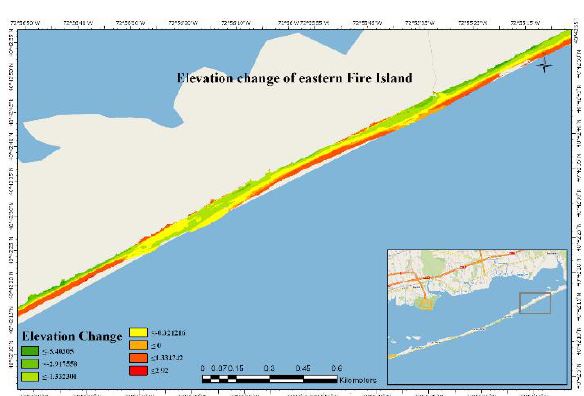
Figure 7. Elevation changes of central Fire Island